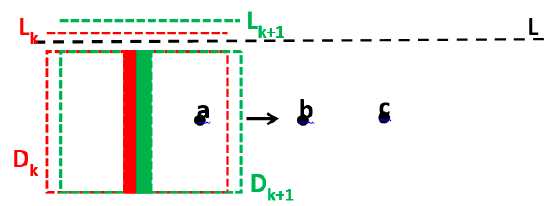
Figure 7. Schematic for the shifting zoom.